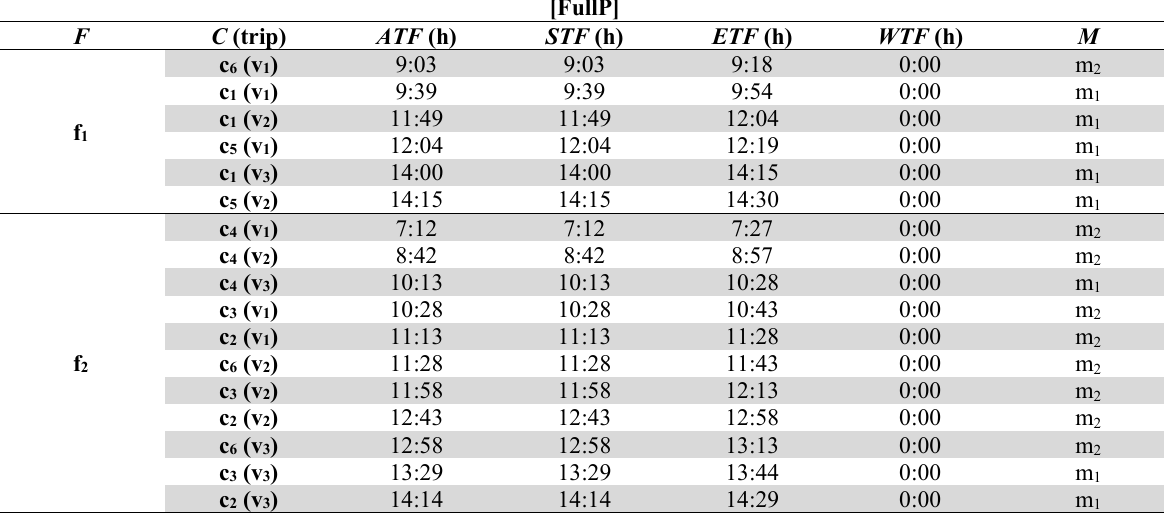
Table 6 Loading scheduling in the harvest